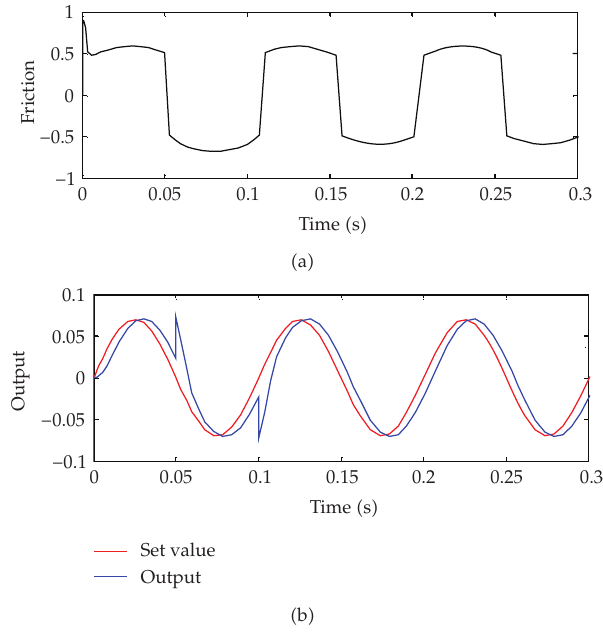
Figure 12: Reference signal is sinusoidal signal of